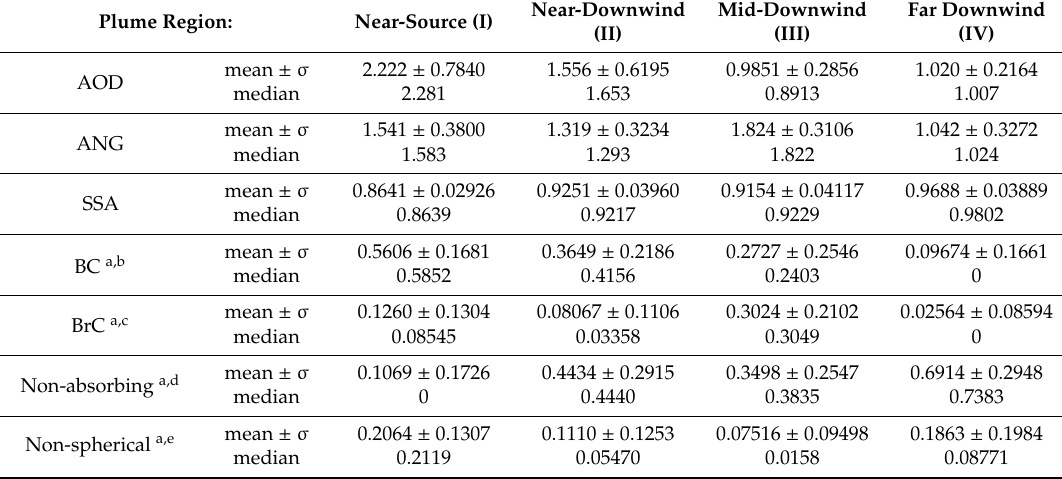
Figure 5. The absolute and fractional AOD of various MISR components for the Government Flats Complex Fire on 21 August 2013, where ( a , b ) are the sum of all “flat,” i.e., BC-like components, ( c , d ) are the sum of all “steep,” i.e., BrC-like components, ( e , f ) are the non-spherical dust-like components, and ( g , h ) are the sum of all non-light-absorbing components. Table 5. MISR-observed particle properties for the Government Flats Complex Fire. AOD—aerosol optical depth; ANG—Ångström